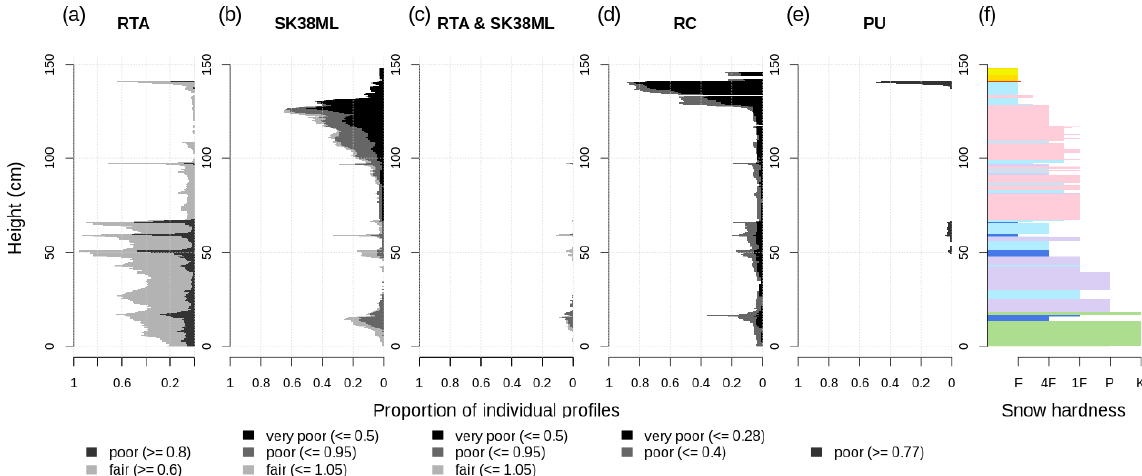
Figure 3. The average profile enables users to compare the distributions of different stability indices. Panels (a–e) show the proportion of individual profiles that contain layers with poor stability as diagnosed by the threshold sum approach (TSA, i.e., lemons) (Schweizer and Jamieson, 2007; Monti et al., 2012, 2014), the relative threshold sum approach (RTA) (Monti and Schweizer, 2013), the multi-layered skier stability index (SK38ML) (Monti et al., 2016), the critical crack length (RC) (Richter et al., 2019), and the most recent random forest classifier p_unstable (PU) (Mayer et al., 2022). Panel (f) shows the corresponding average profile (on 20